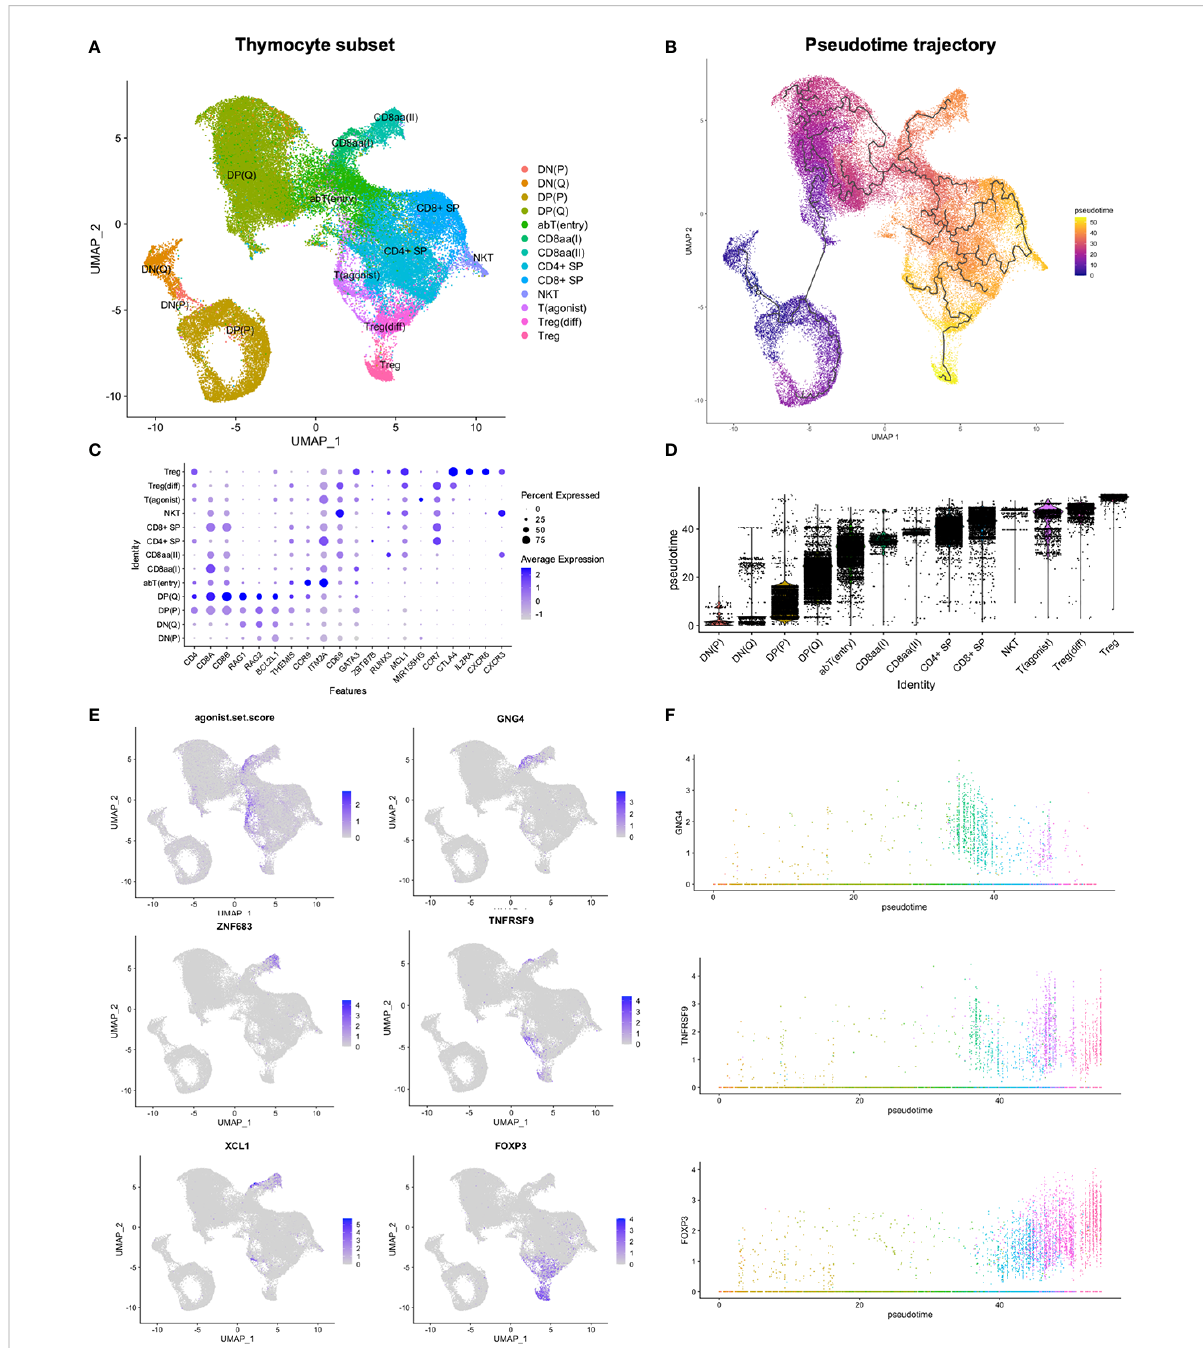
FIGURE 2 Reanalysis of thymocyte subset. (A) UMAP of thymocyte subset. (B, D) Pseudotime analysis by Monocle3. (C, E) Expression of selected genes in thymocyte subset. The agonist.set.score re fl ects the mean expression of NR4A1, NR4A3 , NFKBID, NFATC1, BCL2L11 and PDCD1. (F) Expression of selected genes in thymocyte subset along pseudotime. Colouring according to annotations in (A)